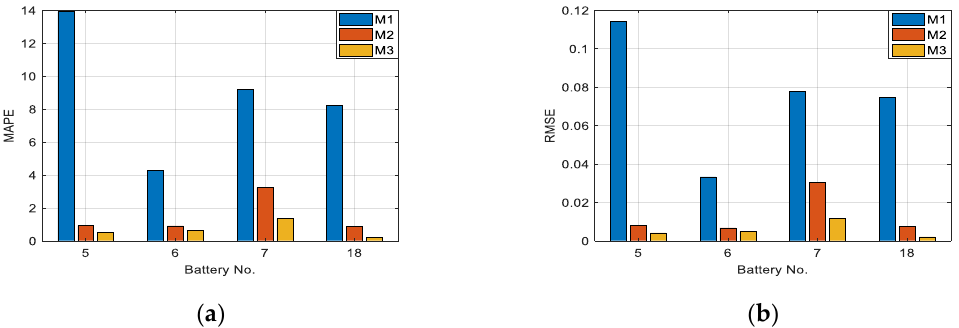
Figure 6. MAPE and RMSE values in comparison experiments: ( a ) MAPE; ( b ) RMSE.